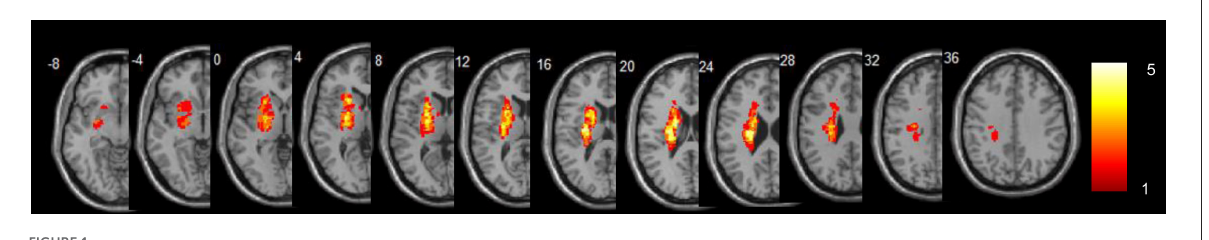
FIGURE1 Lesion overlay map displaying regions of lesion overlap between participants. The n -value denotes the number of patients with a lesion in each voxel. L,